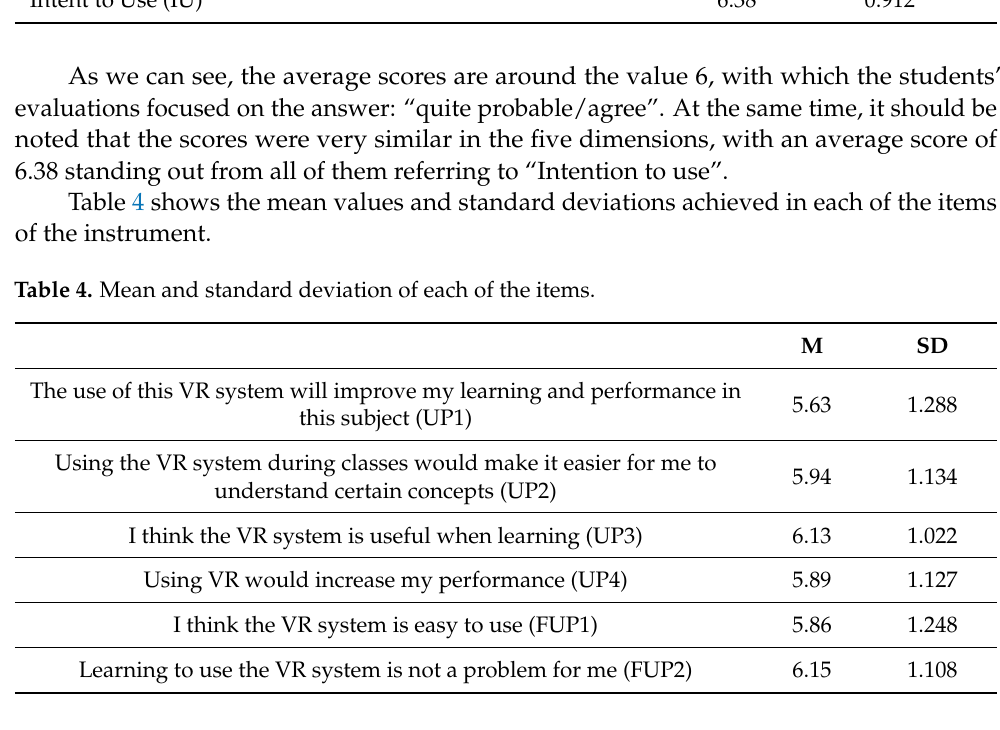
Table 4. Mean and standard deviation of each of the items.